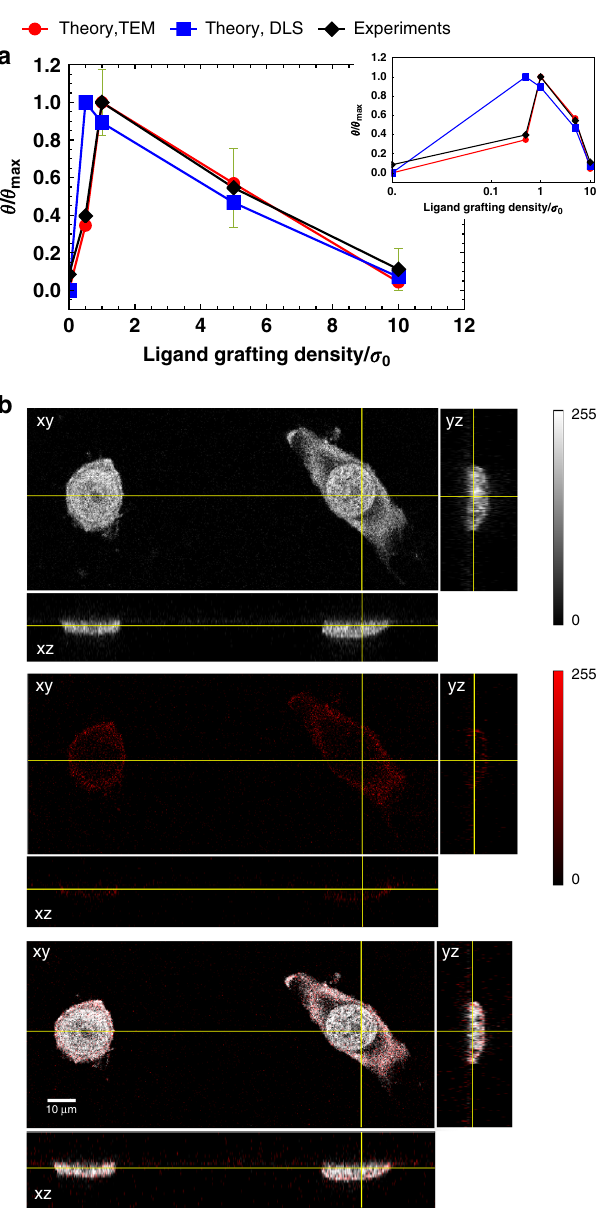
Fig. 4 Experimental observation of range selectivity and theoretical analysis. a Adsorption probability θ (normalised by its maximum value θ ), as a function of grafting density σ (normalised by its value at 1% max loading σ 0 ), comparison of theory vs experimental data. Lines between data points are only a guide to the eye. The theoretical points have been calculated using the expression in Eq. (1), using a Poisson average over both the number of receptors and over the number of ligands, whose average value for the 1% loading of ligands (corresponding to a grafting density of ligands σ L / σ ref = 1), was used as a fi tting parameter. Size polydispersity of the particles was also taken into account, by using the experimentally measured mean and variance at each ligand grafting density, see the Supplementary Methods II. Experimental error bars were calculated as the mean-square root deviation from the average over three independent measurements. See the Method section for more details on both the fi tting procedure and the experimental measurements. b Orthogonal projections of CellMask ™ Green stained cellular membrane after 1 h of incubation with Cy 5 -polymersomes functionalized with 2% Angiopep ligand. Note